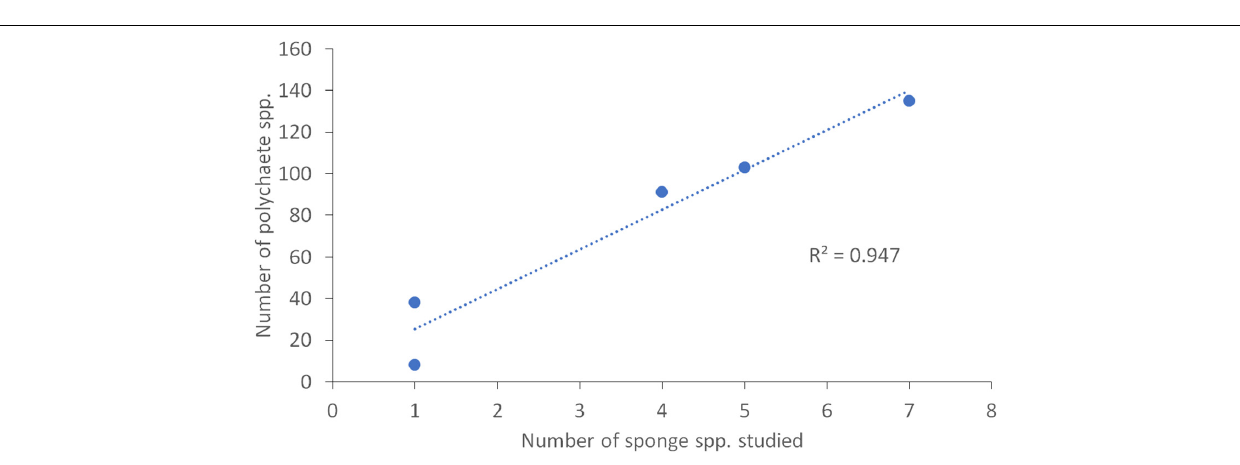
FIGURE 4 | Correlation between the number of sponge-associated species and the number of host sponge species studied in each zoogeographic region in the Mediterranean